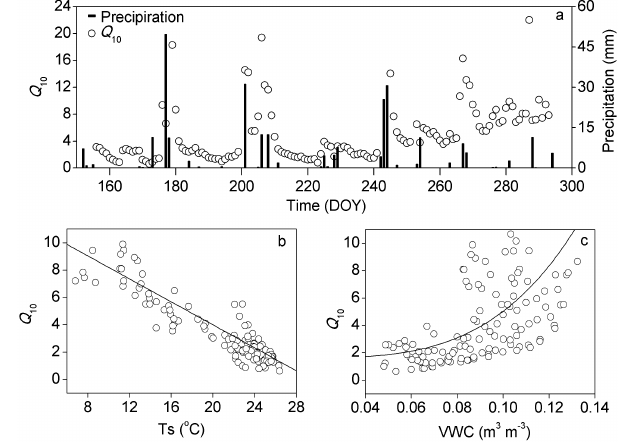
Fig. 7. Relationship between normalized daily mean soil respiration (Rs N ) and volumetric soil water content (VWC). Rs N is the ratio of the observed soil respiration (Rs) value to the value predicted by the logistic model. The solid line is fitted using linear regression.